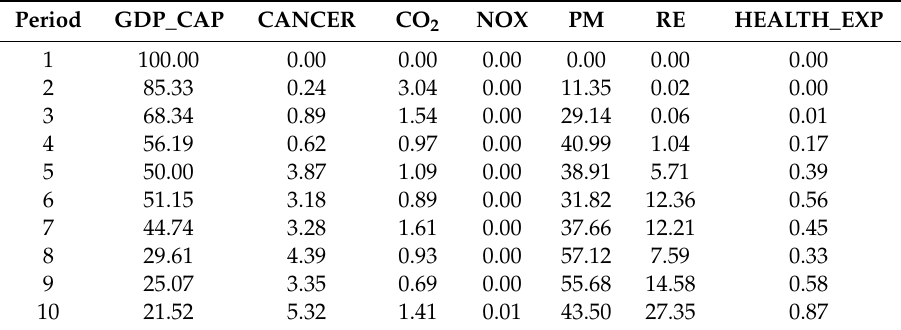
Table 8. Variance decomposition of GDP_CAP.